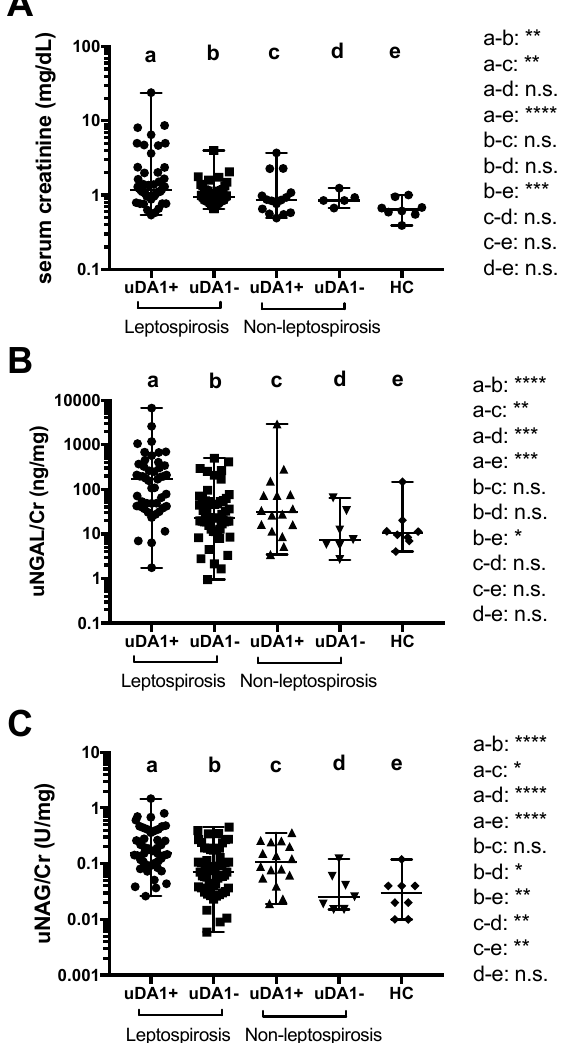
Figure 3. Differences in serum Cr ( A ); uNGAL/Cr ( B ); and uNAG/Cr ( C ) levels between uDA1-positive and -negative groups in leptospirosis and non-leptospirosis patients and HCs. * p < 0.05; ** p < 0.01, *** p < 0.001, **** p < 0.0001, n.s. not significant.